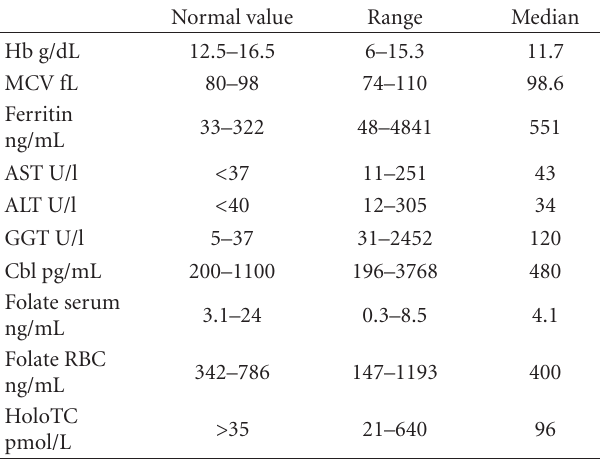
Table 1: Alcoholic patients: sex, age, hematologic, and metabolic